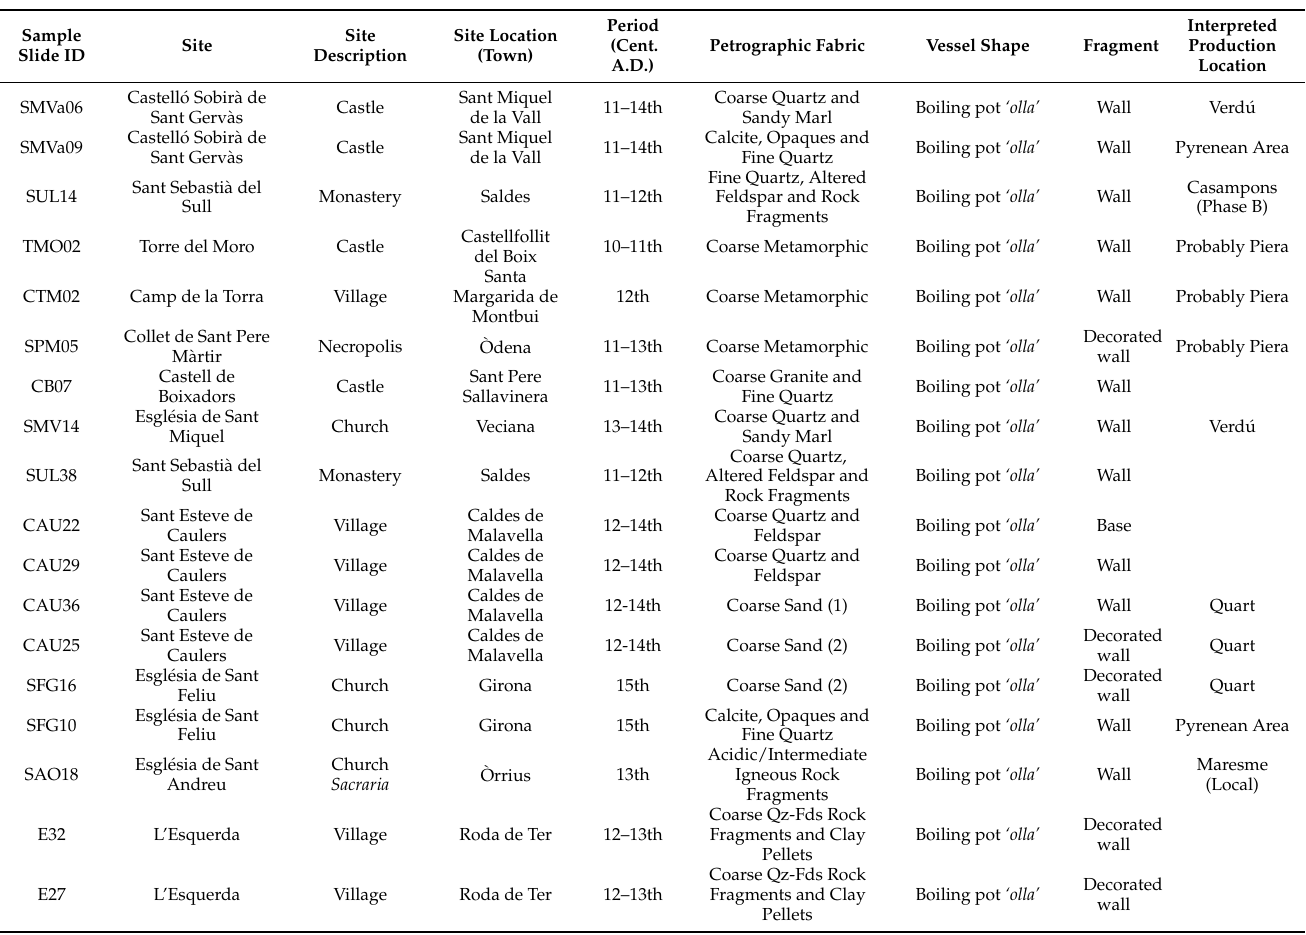
Table A1. Details of the archaeological context for the 40 medieval greyware pottery samples analysed in this paper, including their site of origin and location, chronology, petrographic fabric, vessel shape, fragment and interpreted production location. Samples keep the same order as in Table